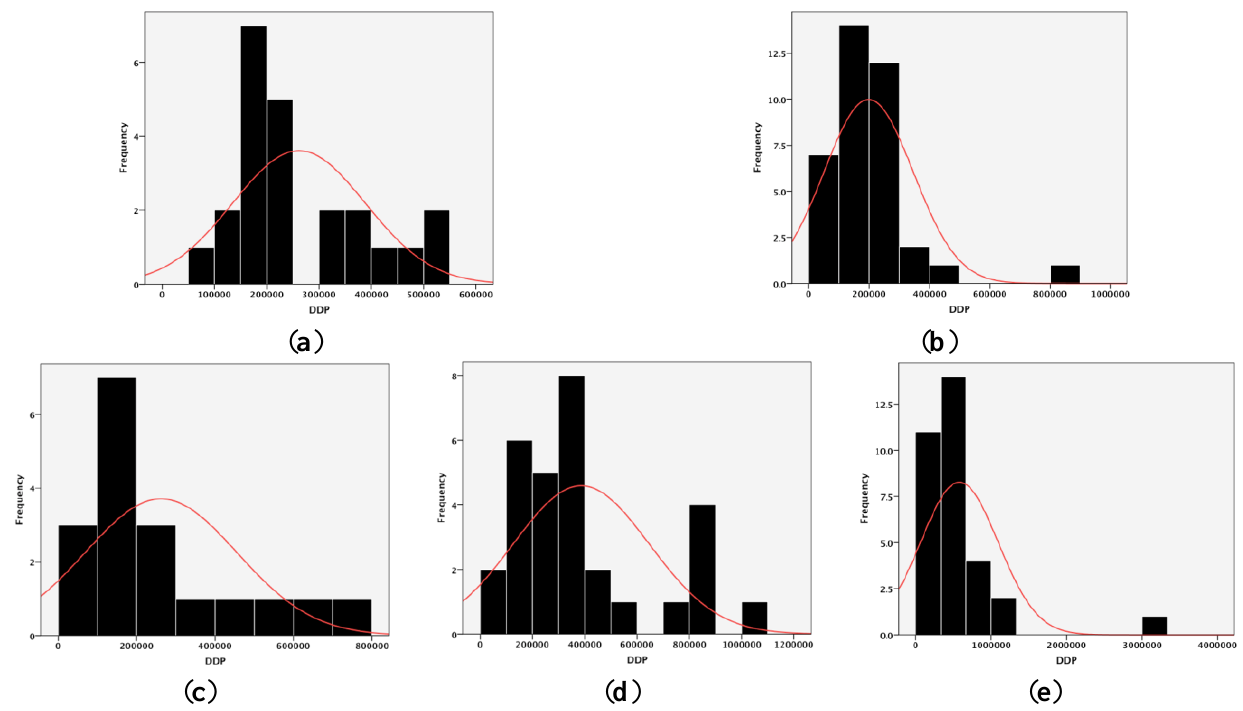
Figure 2. Distribution of DDP in nine states of India: ( a ) Assam; ( b ) Bihar; ( c ) Jharkhand; ( d ) Odisha; ( e )